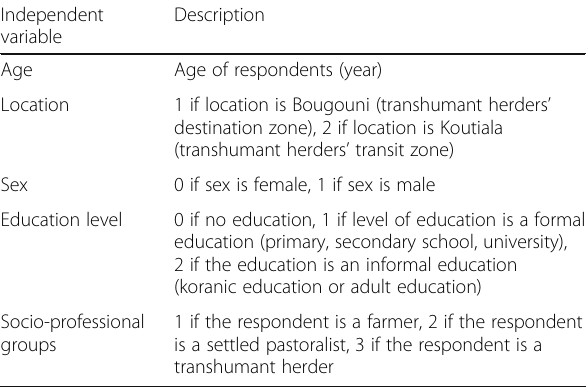
Table 2 Description of the independent variables used in the regression